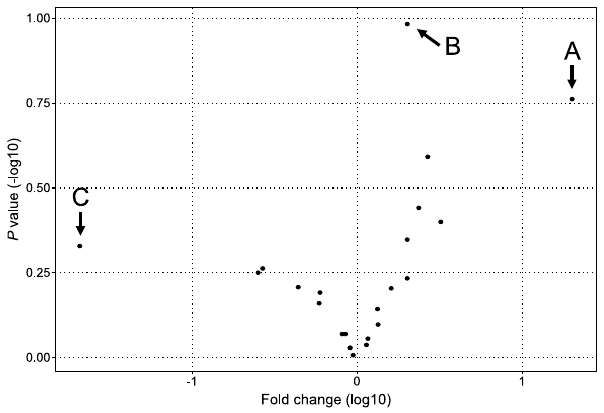
Figure 3 Volcano plot of the relative abundance of each bacterial genus. The x-axis indicates the fold changes of genera in PD samples compared with non PD samples, while the y-axis indicates P values. A. Finegoldia (20-fold, P =0.17); B. Lactobacillus (2-fold, P =0.10); and C. Bifidobacterium (0.02-fold, P =0.46).